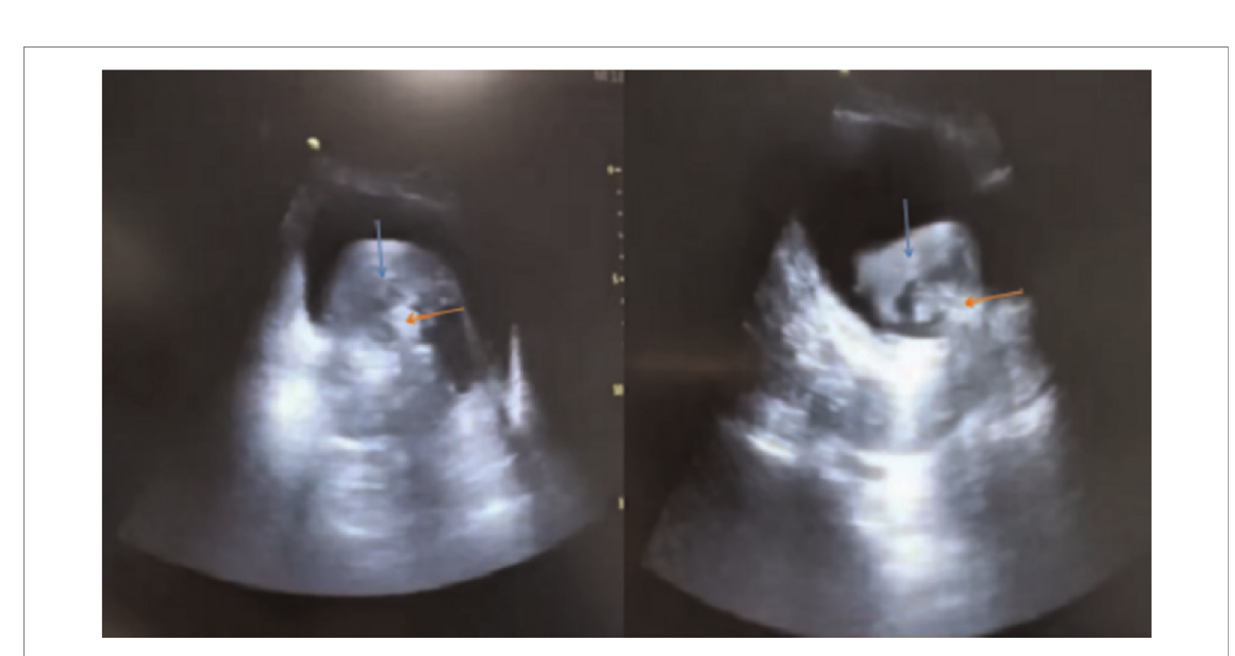
FIGURE 4 The morcellator in the centre of the blood clots under ultrasound guidance (blue arrow: blood clot; Red arrow: